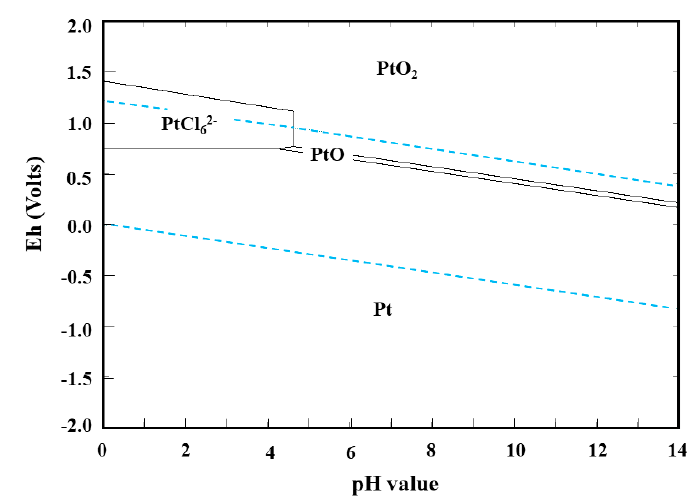
Figure 1. The Eh–pH diagram of Pt–Cl–H 2 O system at 25 °C using HSC software. (c(Pt) = 0.001 mol/L, c(Cl − ) = 6.0 mol/L).